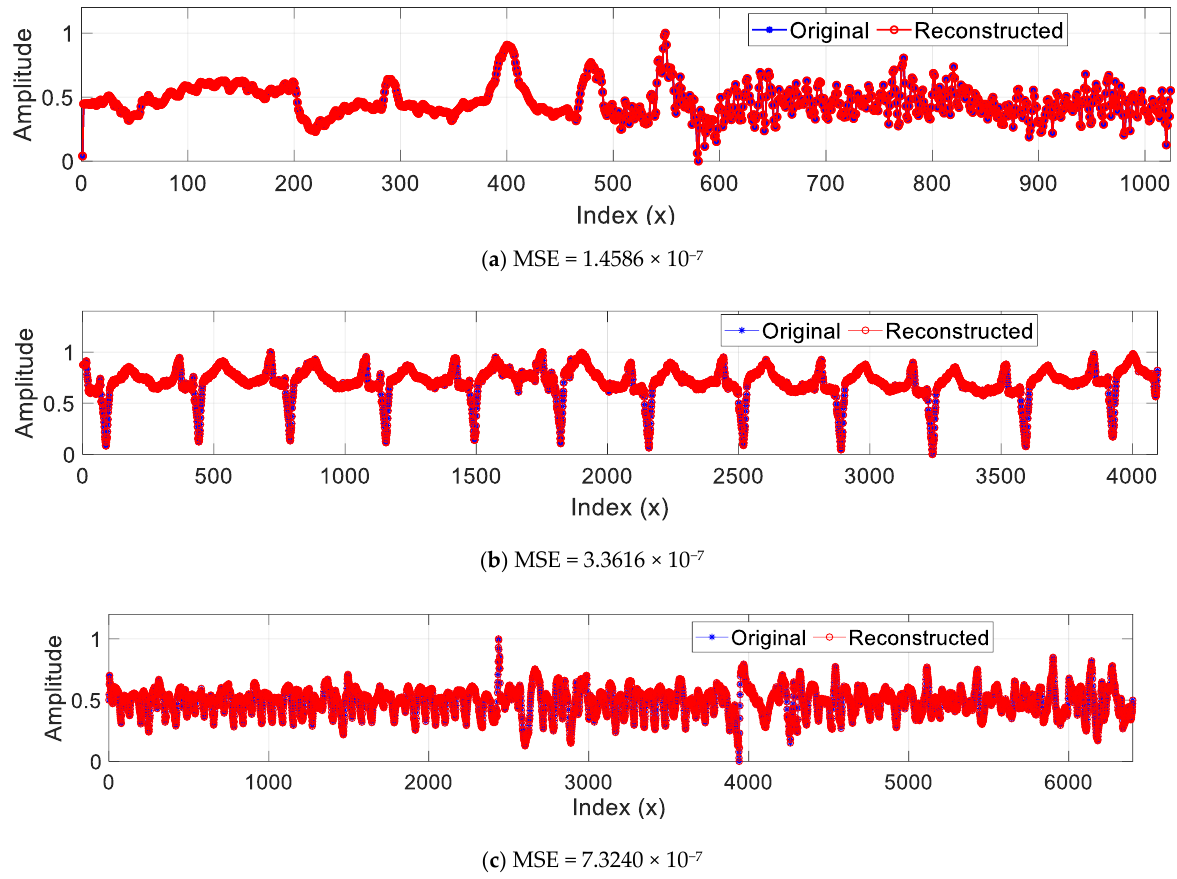
Figure 15. ( a – c ) Original and reconstructed bio-signal frames using 2DHMs.